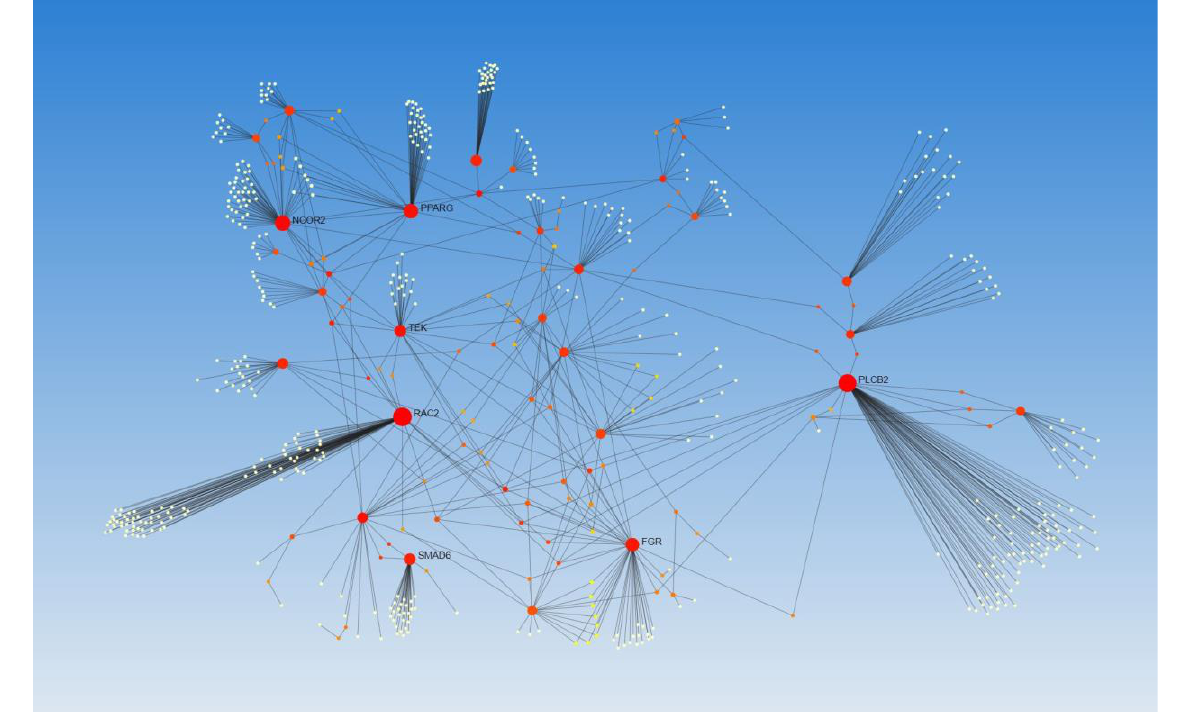
Figure 4. STRING analysis for protein-protein interaction. The analysis showed that various DEGs are related to each other and regulate each other.